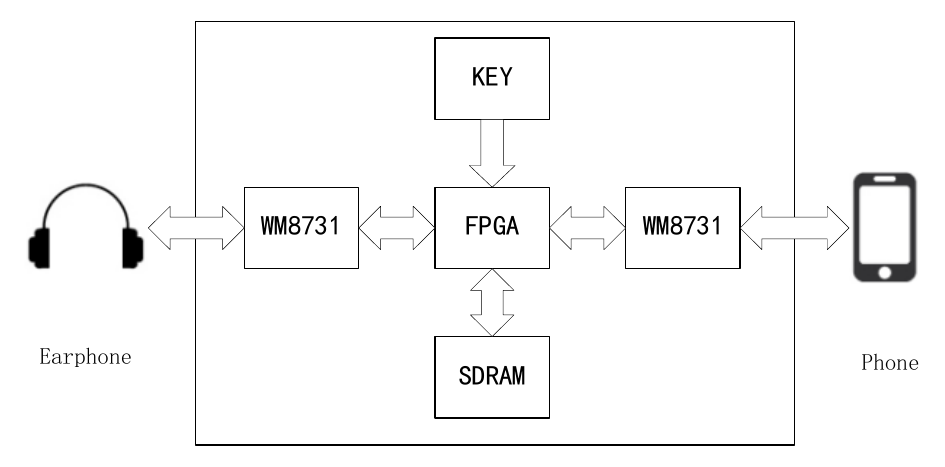
Figure 1. Voice encryption system architecture.